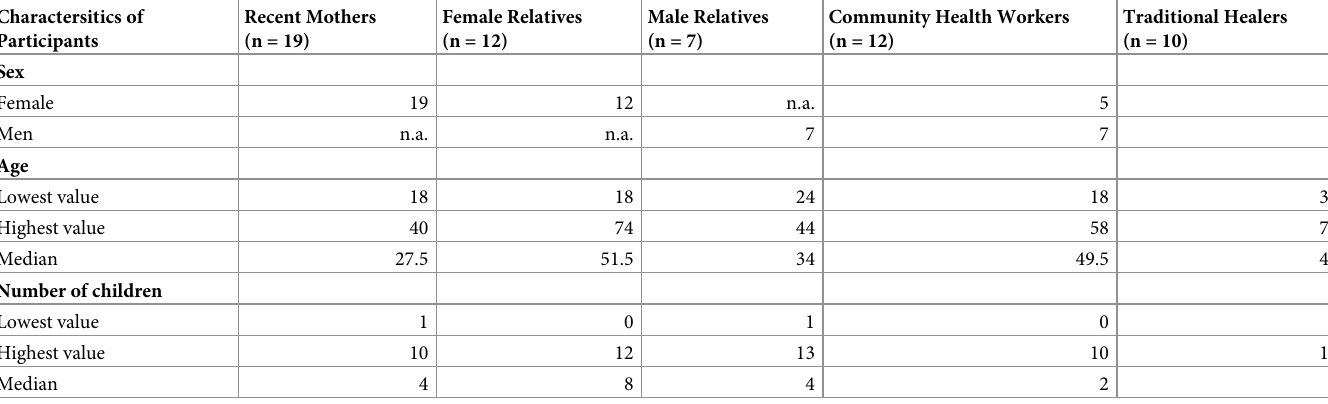
Table 1. Demographic information of study participants. Charactersitics of